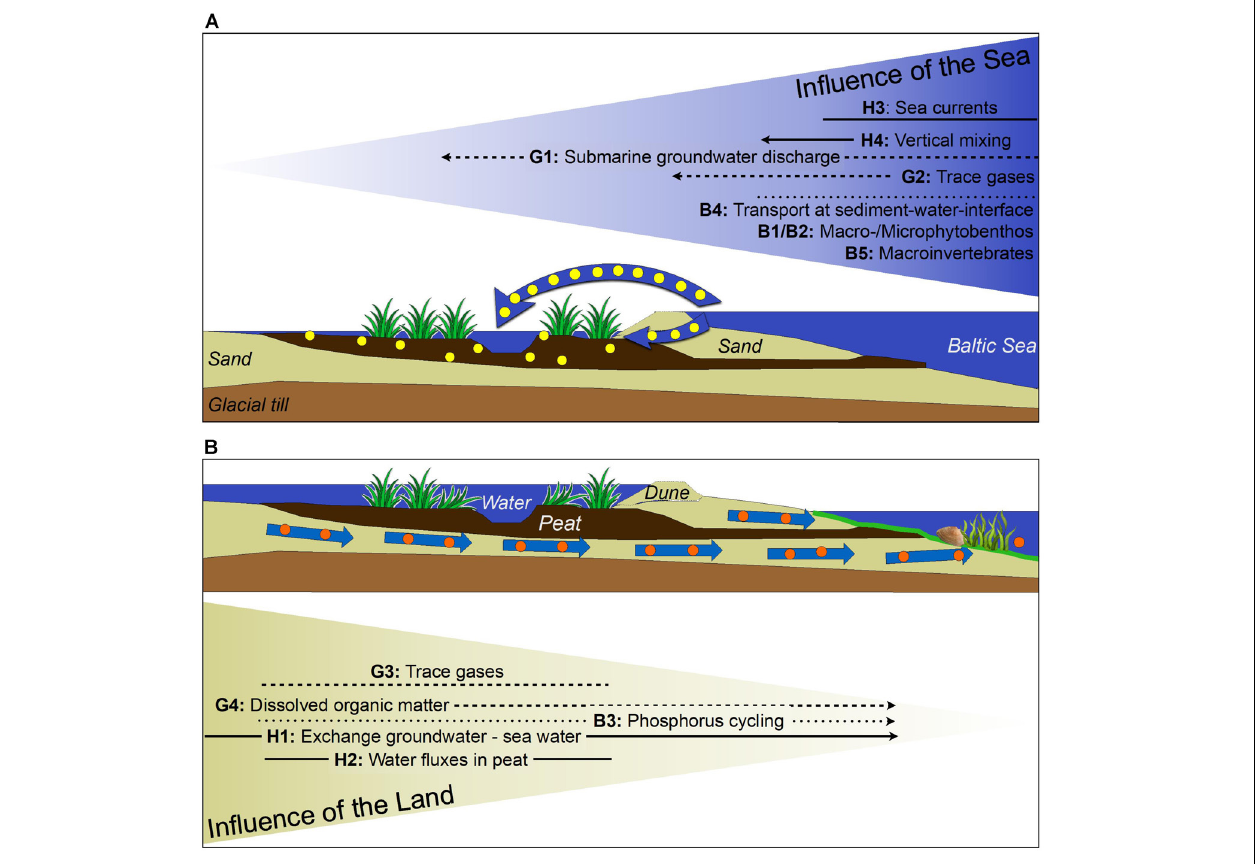
FIGURE 2 | Baltic TRANSCOAST scheme showing the spatial coverage of the different research topics (—- H —- hydro-physical, --- G --- biogeochemical, ···· B ···· biological) and the prevailing water and substance exchange pathways across the coast line at two different possible states: (A) During storm surge events brackish seawater flows into the coastal peatland (above surface and through the sediment); (B) When the groundwater and surface water levels at the land side are high during winter, submarine groundwater discharge (SGD) may export nutrients and dissolved organic matter (DOM) to the shallow sea (not to scale). The spread of the lines indicate the spatial coverage of the respective topic across the coastal ecocline. Arrowheads indicate that those topics have a specific focus on exchange in the direction of the arrow. Non-arrowed topics consider two-way exchange processes